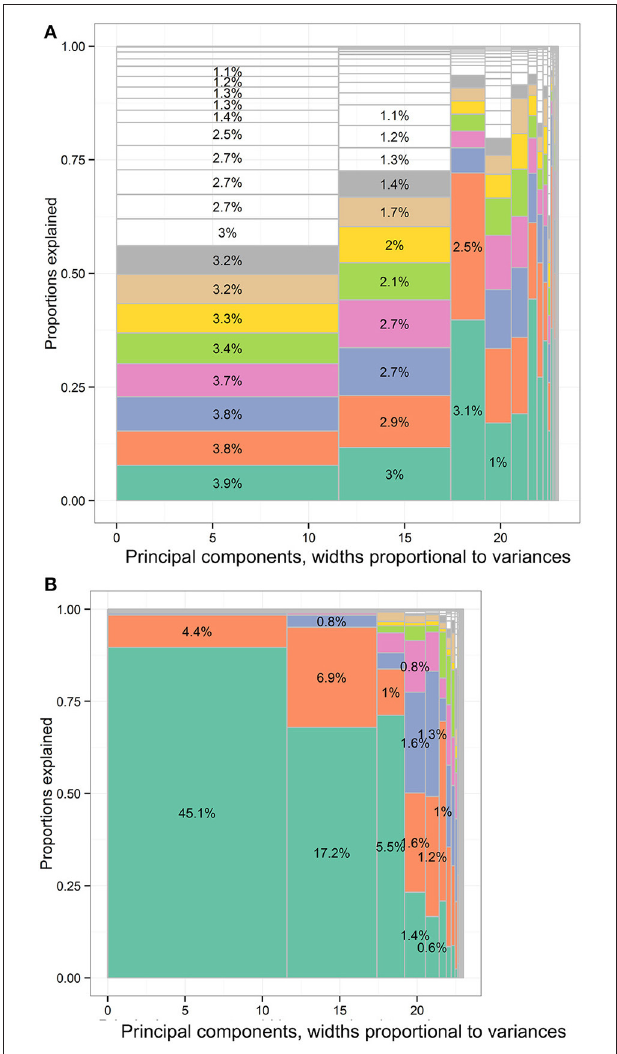
FIGURE 11 | The distribution of total variances by principal components and input variables or approximation variables in the Canadian Health Measures Survey spirometry subset data set. Principal components, widths proportional to variances. (A) The distribution of variances of the spirometry subset according to the PCA loadings. There were 23 columns separated by solid vertical gray lines. Principal components, widths proportional to variances. (B) The distribution of variances of spirometry subset of the CHMS cycle 1 to 3 according to the forward regression. There were 23 columns separated by solid vertical gray lines. CHMS, Canadian Health Measures Survey; PCA, principal component analysis. Each column represented the principal components (PCs) and had widths the same as the PC variance. In each column, the cells were of unequal sizes representing the variances explained by the input variables. For each PC specified in each column, the PC was explained by input variables. The cells in each column represented the input variables. The cell sizes were proportional to how much the PCs were explained by input variables. The cells were ordered by the variances explained by input variables or cell sizes. The variable names were not specified in the graph for limited spaces. The eight leading cells in each PC column were colored as a visual aid to highlight the numbers of input variables used to interpret the PCs. The cells of leading sizes were labeled with the proportions of total variances. The gray area represented the cells of small sizes and the cells were in gray color because the sizes of the white cells were smaller than the line widths of gray